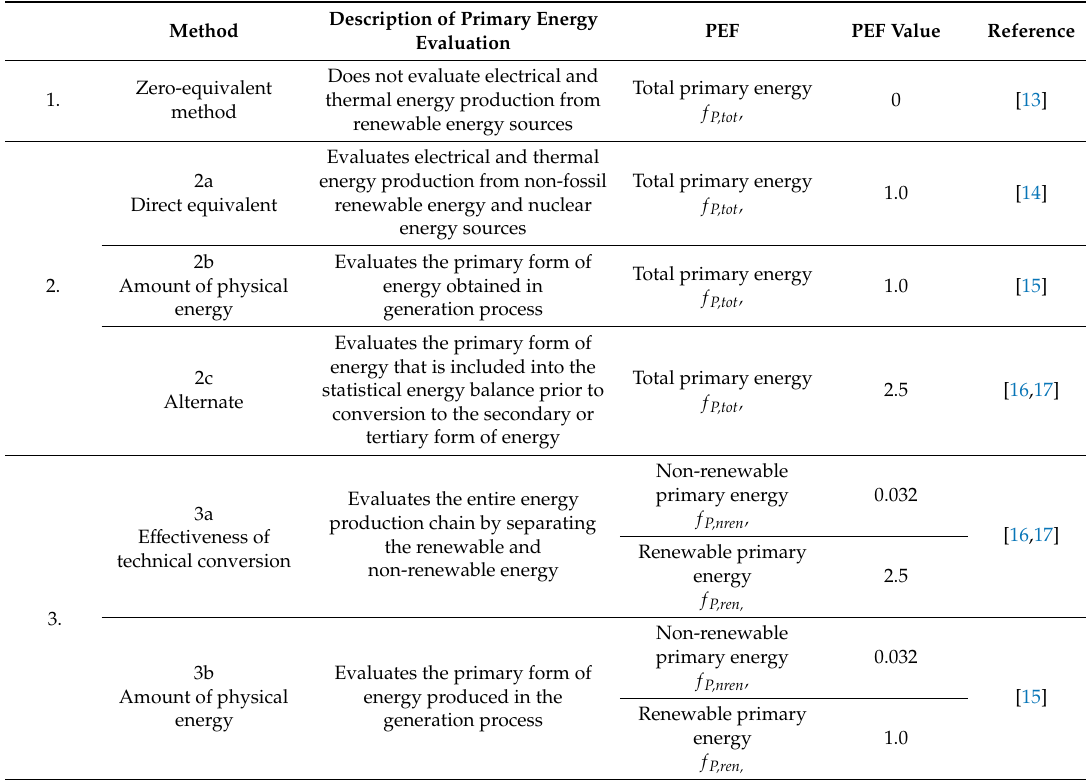
Table 1. Parameters of di ff erent methodologies for the evaluation of primary energy produced from wind turbines.